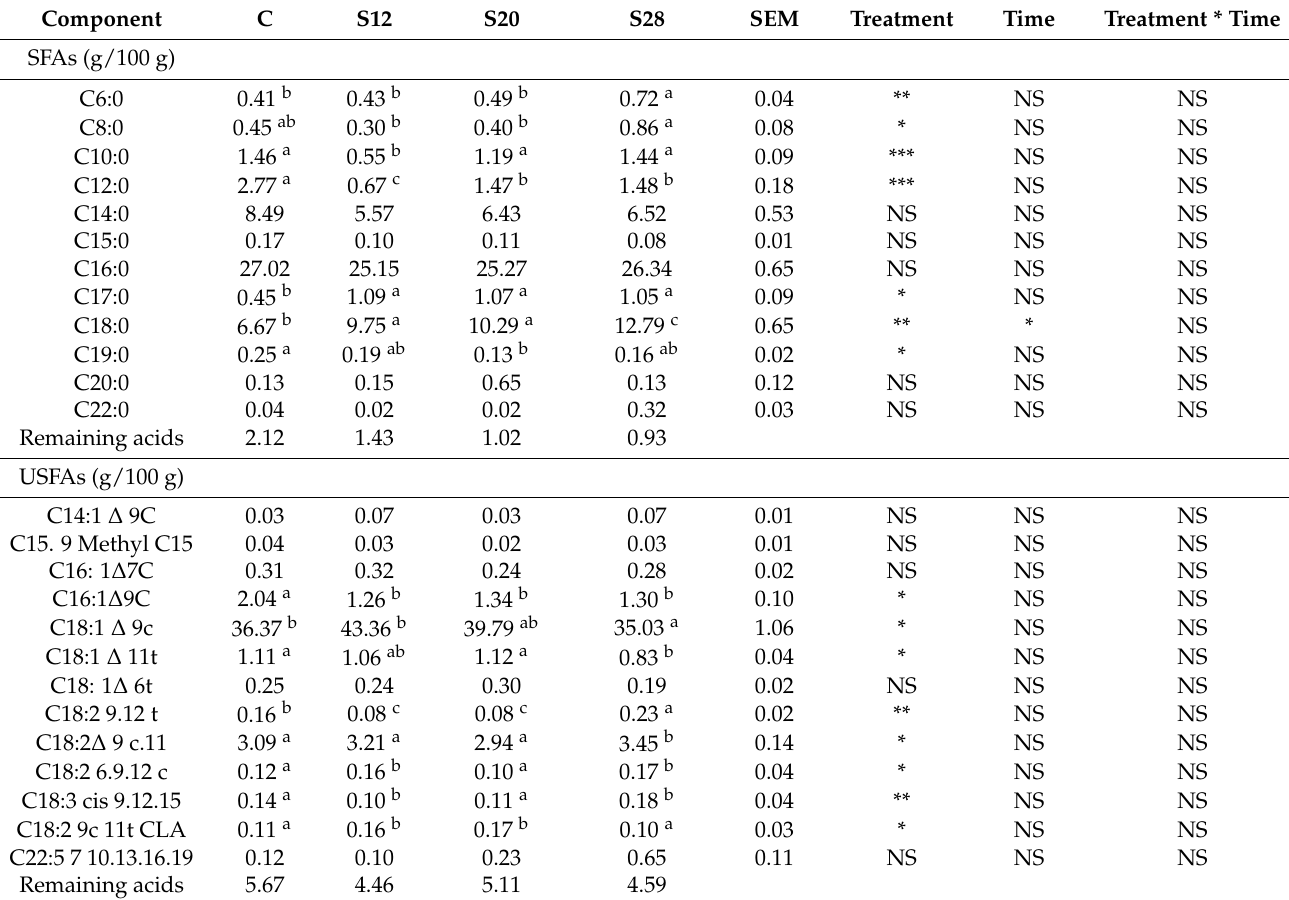
Table 5. Fatty acids profile of colostrum samples from ewes fed different levels of sunflower